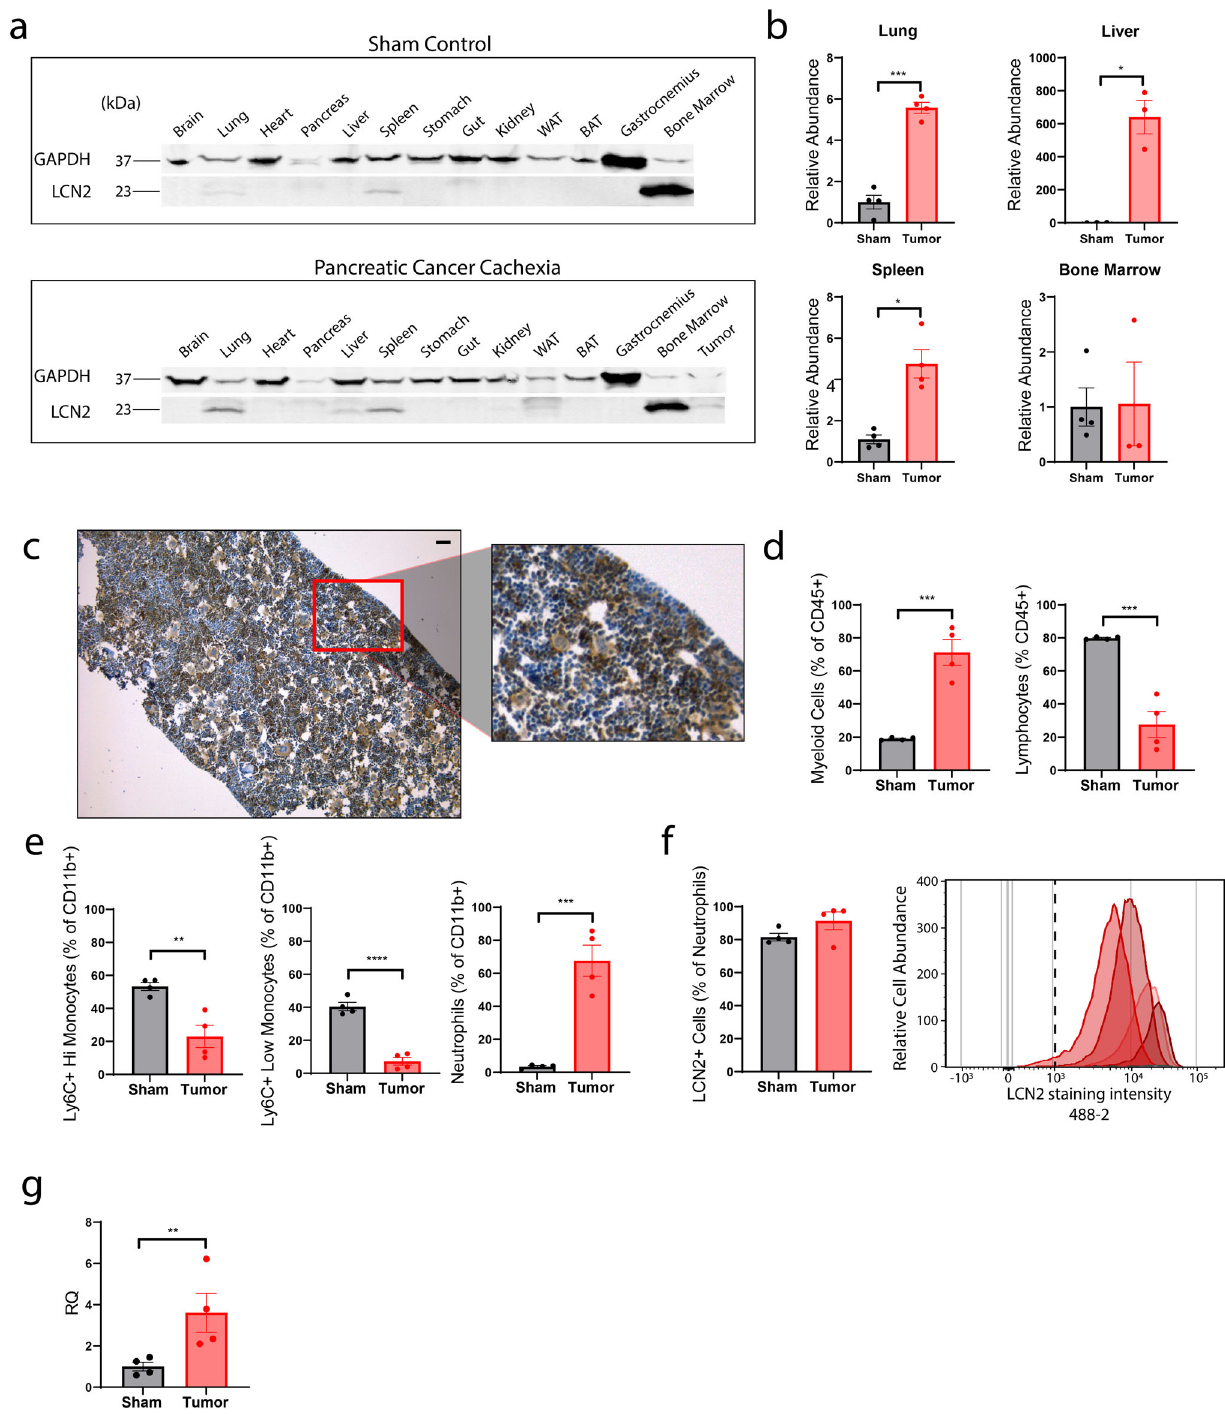
Fig. 2 LCN2 is predominantly produced by the bone marrow compartment and neutrophils during cachexia. a Representative tissue Western blot analysis of LCN2 in sham operated or pancreatic cancer cachexia mice (orthotopic KPC pancreatic cancer cell implantation). b Western blot quanti fi cation of LCN2 in lung, liver, spleen, and bone marrow compartments ( n = 4 per group, except in KPC-engrafted liver and bone marrow samples [ n = 3 per group]). c Representative immunohistochemistry staining images of LCN2 in the bone marrow of cachectic mice; 10× and high-resolution inset (scale bar = 50 µ m). d , e Flow cytometry analysis to detect myeloid and lymphoid populations and myeloid cell subpopulations. f Flow cytometry quanti fi cation of intracellular LCN2 in Ly6G + neutrophils; accompanying fl uorescent intensity histogram, capturing relative abundance of Ly6G + LCN2 + neutrophils between sham (gray lines) and cachectic (red lines) groups. The Ly6G + cell population in the sham group is suppressed to the X -axis by the relative abundance found in the cachectic group. Each curve represents a single subject. Vertical dotted line approximates gating threshold for positive intracellular LCN2 staining. g FACS-sorted neutrophil RNASeq analysis of LCN2 transcripts. d – g N = 4 per group. b , d – g Analyzed by two-tailed Students t tests. a LCN2 molecular weight = 23 kDa, GAPDH = 37 kDa. All data expressed as mean ± SEM. Quantitative data analyzed by Student ’ s t test. * p ≤ 0.05, ** p ≤ 0.01, *** p ≤ 0.001, and **** p ≤ 0.0001. Sham operation controls = gray/black, KPC =